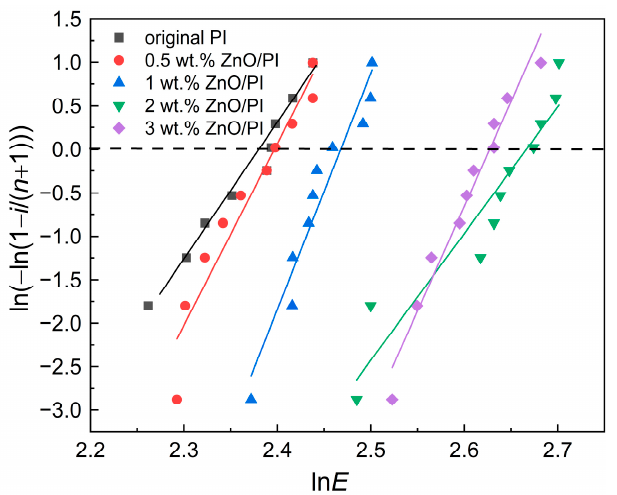
Figure 7. Weibull statistical distribution of the DC surface flashover voltage of ZnO/PI composite films. Table 2. Weibull distribution parameters of surface flashover characteristic of ZnO/PI composite